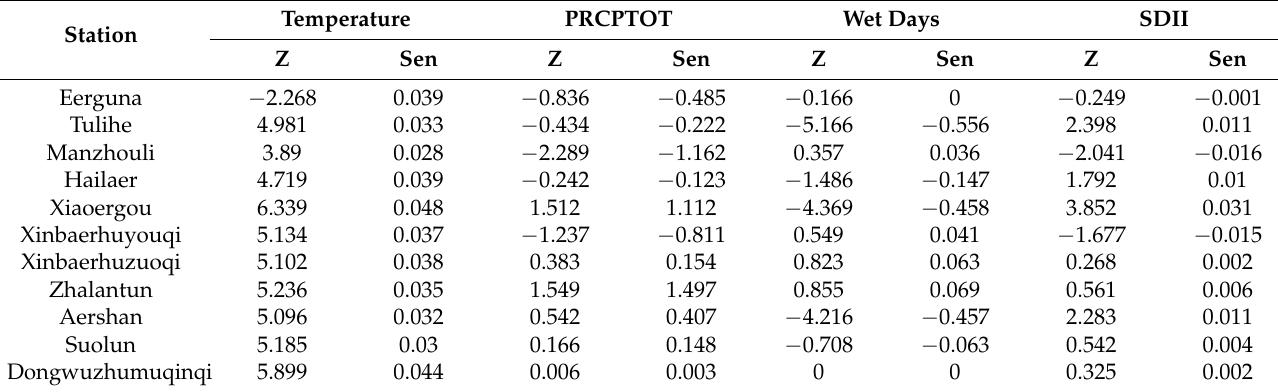
Table 6. Z Value and slope